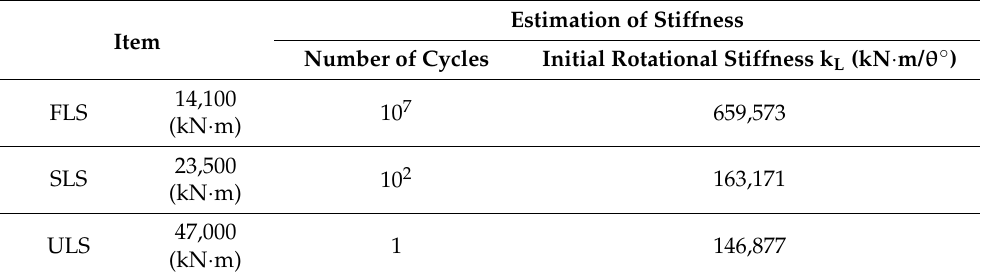
Table 7. Example of estimation of long-term stiffness of on-site OWT.